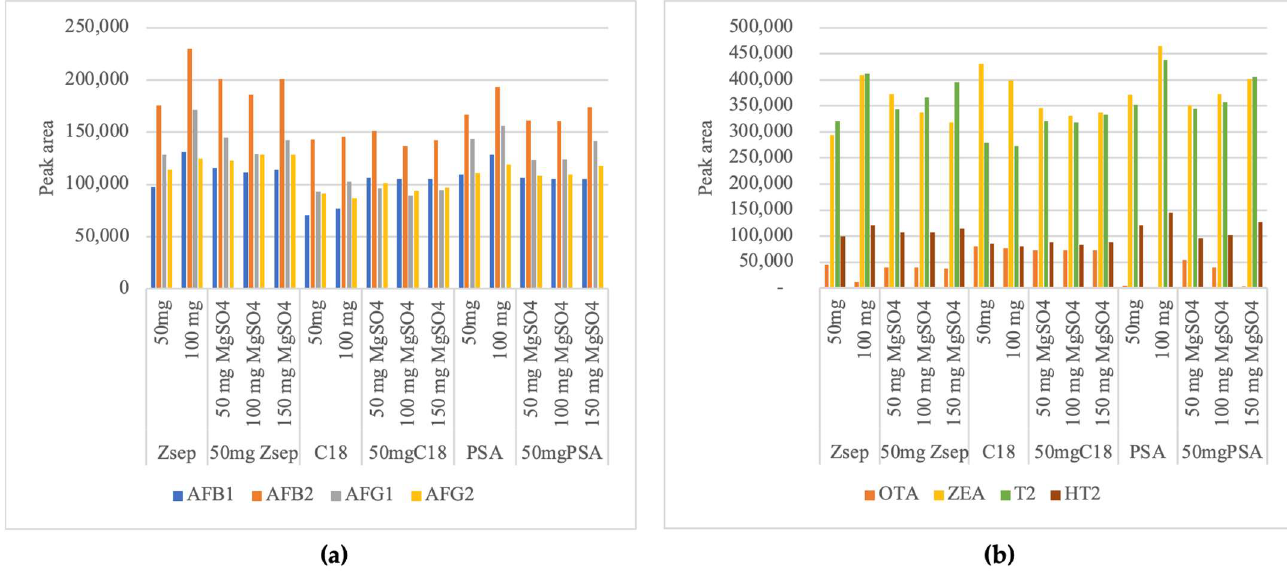
Figure 3. Average peak areas (n = 2) using silica gel with zirconium oxide (Z-Sep), octadecyl modified silica (C18), primary secondary amine (PSA), and magnesium sulfate (MgSO 4 ) sorbents in d-SPE clean-up of ( a ) AFs (AFB1–Aflatoxin B1; AFB2–Aflatoxin B2; AFG1–Aflatoxin G1; AFG2–Aflatoxin G2) and ( b ) Ochratoxin A (OTA), Zearalenone (ZEA), toxin T2 (T2) and toxin HT-2 (HT2).